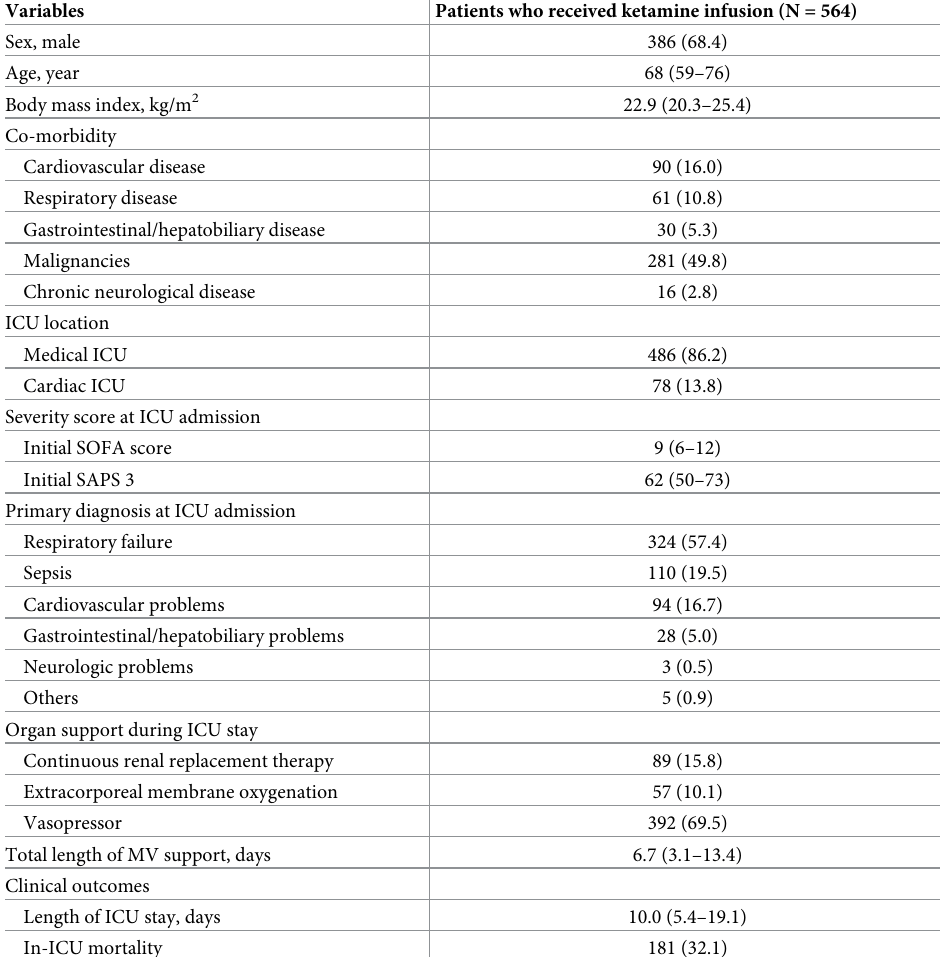
Table 1. Clinical characteristics and clinical outcomes of patients who received continuous ketamine